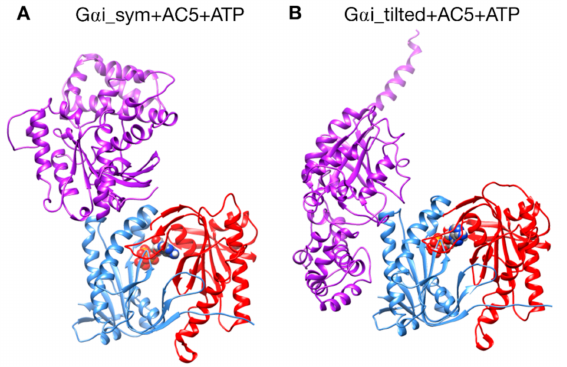
Figure 2. The two di ff erent configurations of the G α i + AC5 + ATP complex simulated in this study. ( A ): G α i_sym + AC5 + ATP: G α i has an orientation symmetrical to the Gs α protein in the AC5 + Gs α complex. ( B ): G α i_tilted + AC5 + ATP: G α i protein is tilted with respect to AC5.